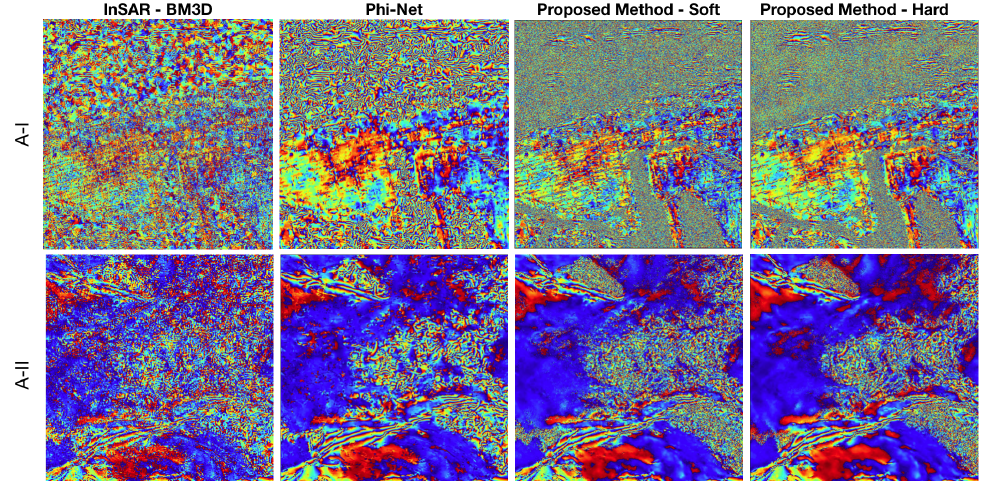
Figure 18. Filtered interferometric phase images of the considered sites A-I and A-II estimated using all the compared